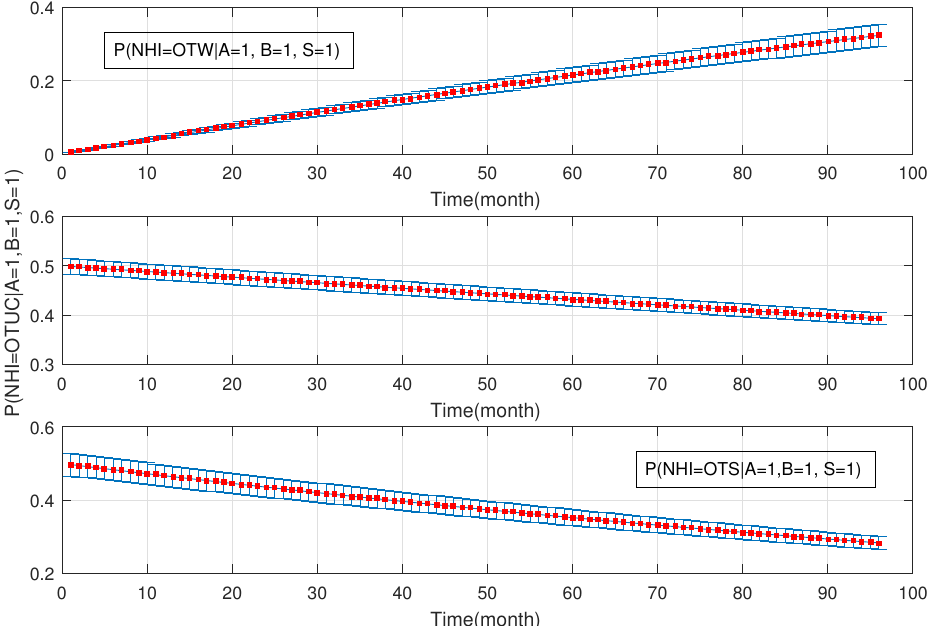
Figure 12. The probability of new herd incident (NHI) (officially TB free status withdrawn (OTW), officially TB free status unclassified (OTUC), officially TB free status suspended (OTS)) in high-risk areas of England where A: cattle are over 24 months, B: badgers density is ( > 3 setts/ha); and S: silage fed.